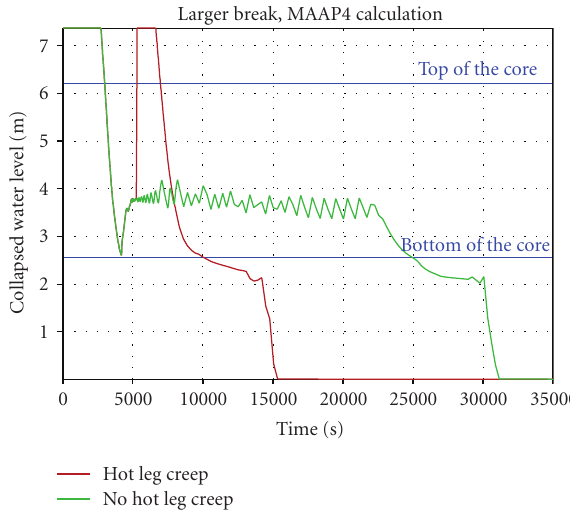
Figure 15: RCS pressure, Group